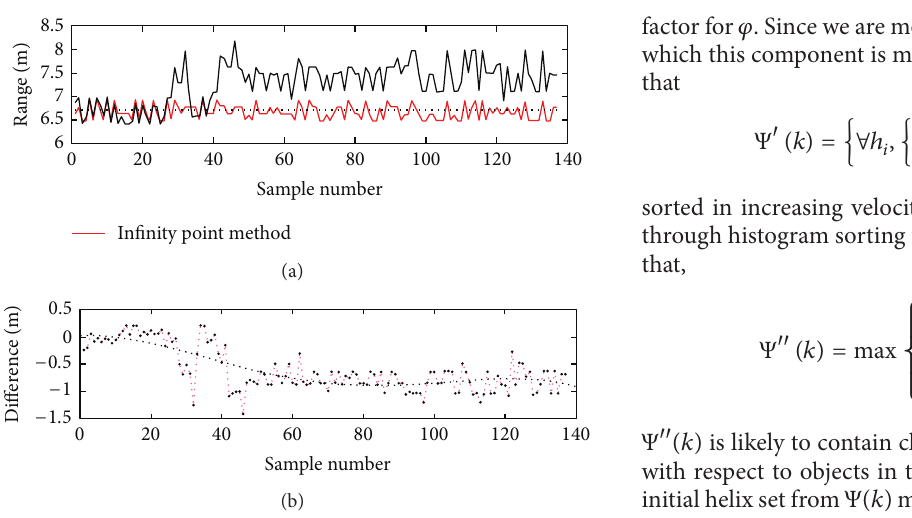
Figure 6: (a) Illustrates the accuracy of the two-range measurement methodswithrespecttogroundtruth(flatline).(b)Residualsforthe top